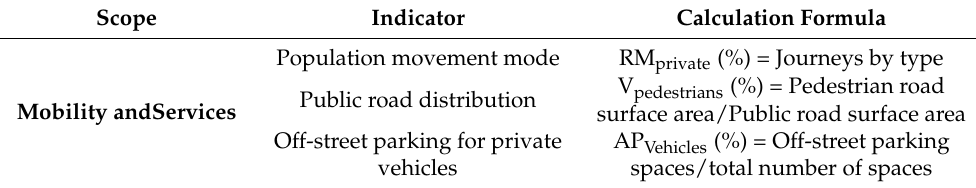
Table 5. Indicators used in the scope of Mobility and